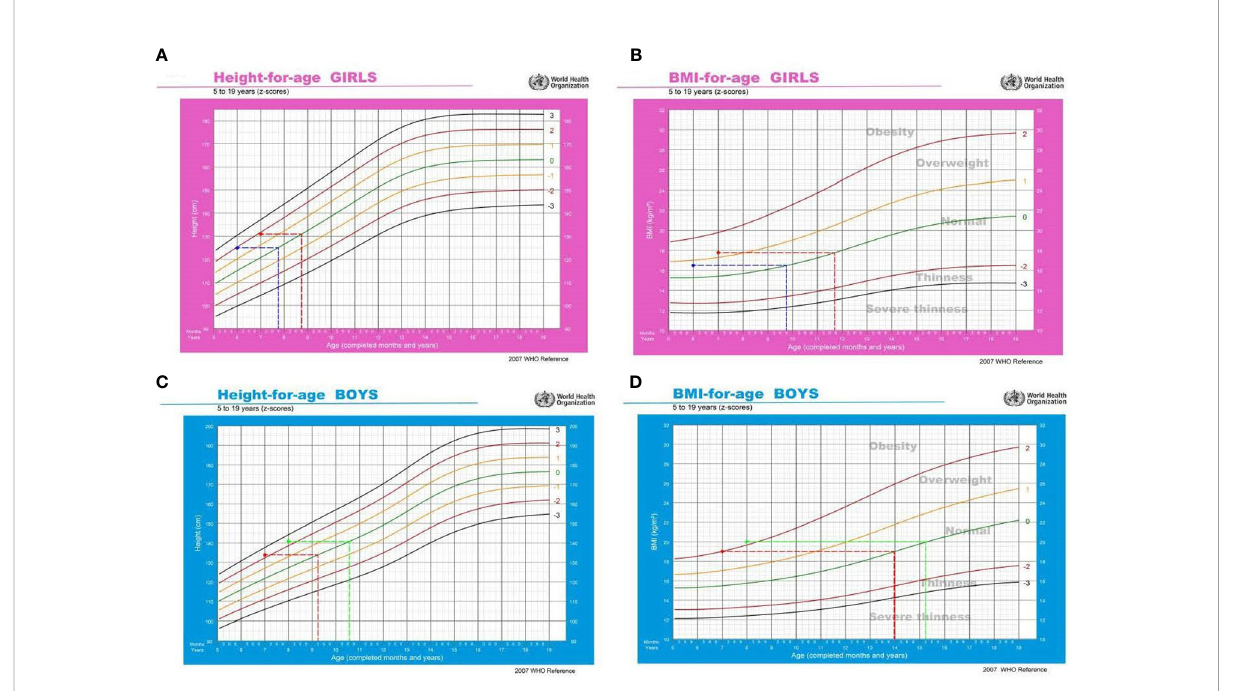
FIGURE 3 Relationship between precocious puberty and physical growth. In Figures (A, B) , the blue line refers to girls with Tanner stages ≥ II at 6-year-old, and the red line refers to girls with Tanner stages ≥ II at 7-year-old. In Figures (C, D) , the red line refers to boys with Tanner stages ≥ II at 7-year- old, and the green line refers to boys with Tanner stages ≥ II at